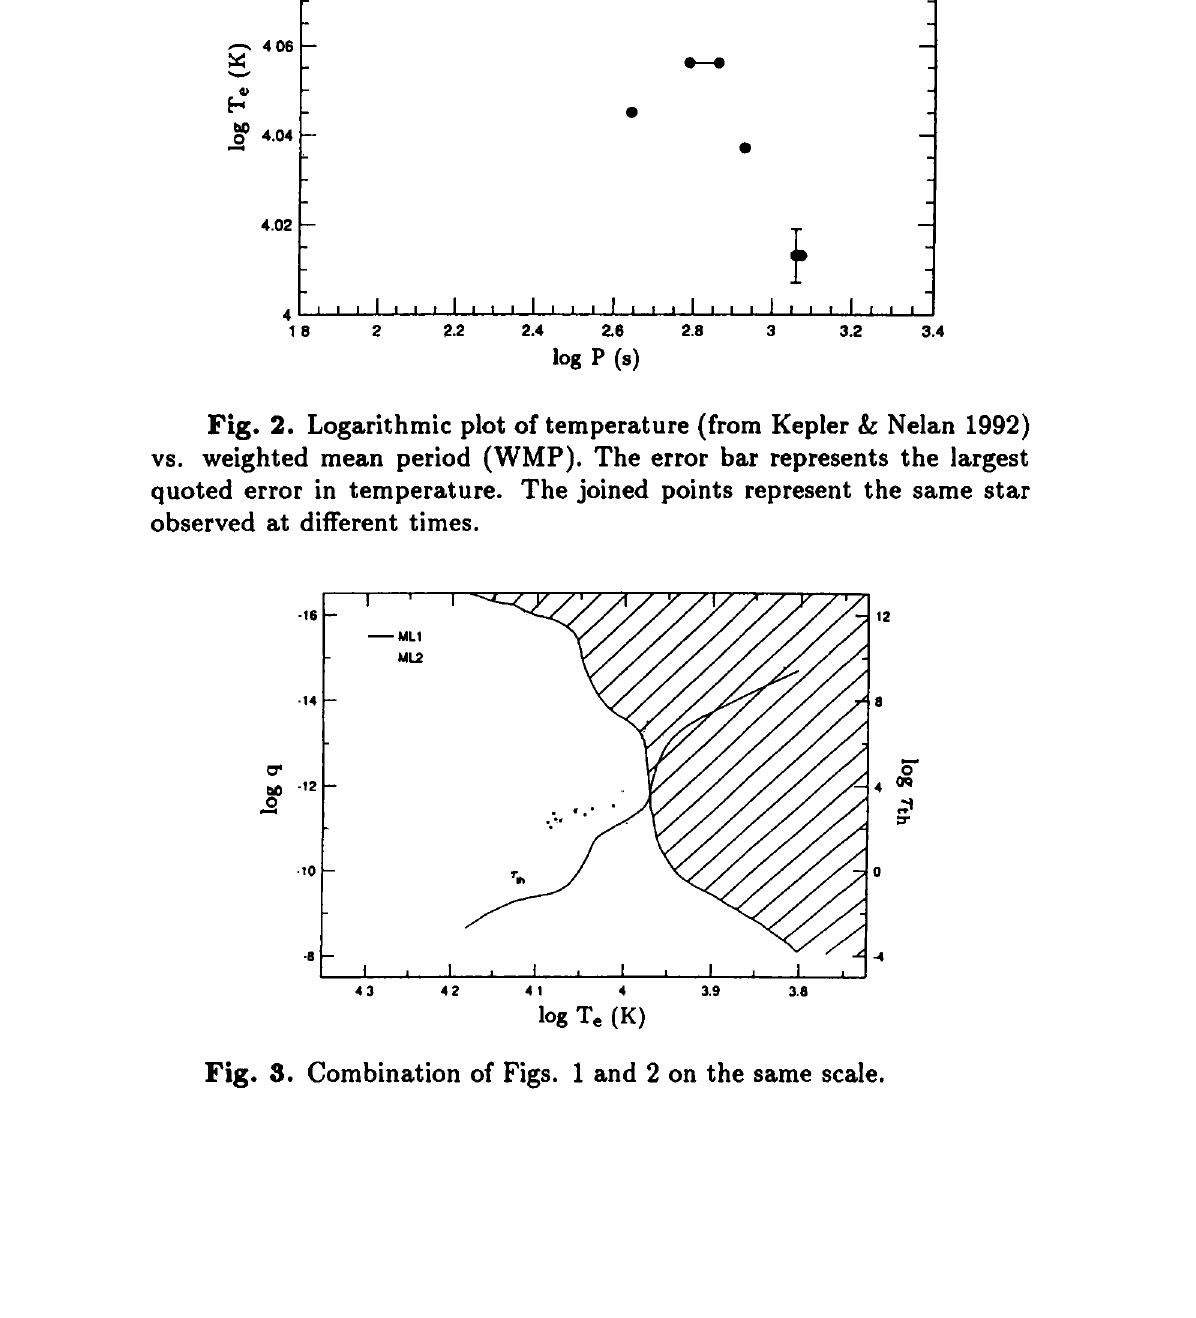
Fig. 3. Combination of Figs. 1 and 2 on the same